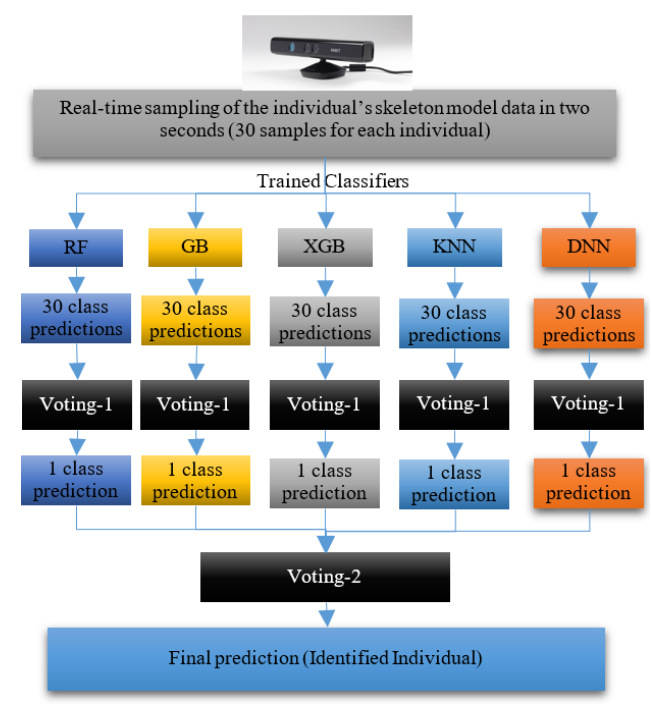
Fig. 3. The architecture of cascade voting